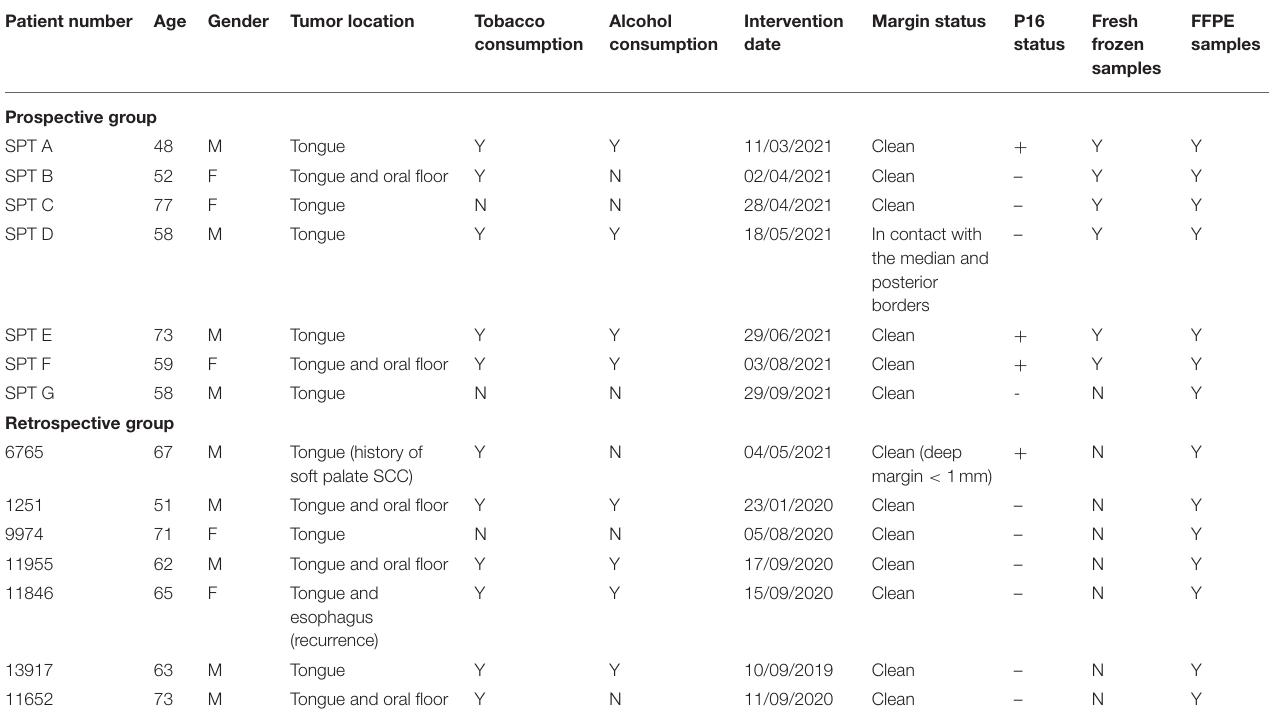
TABLE 2 | Detailed demographic, clinical, and sample data of the patient. Patient number Age Gender Tumor